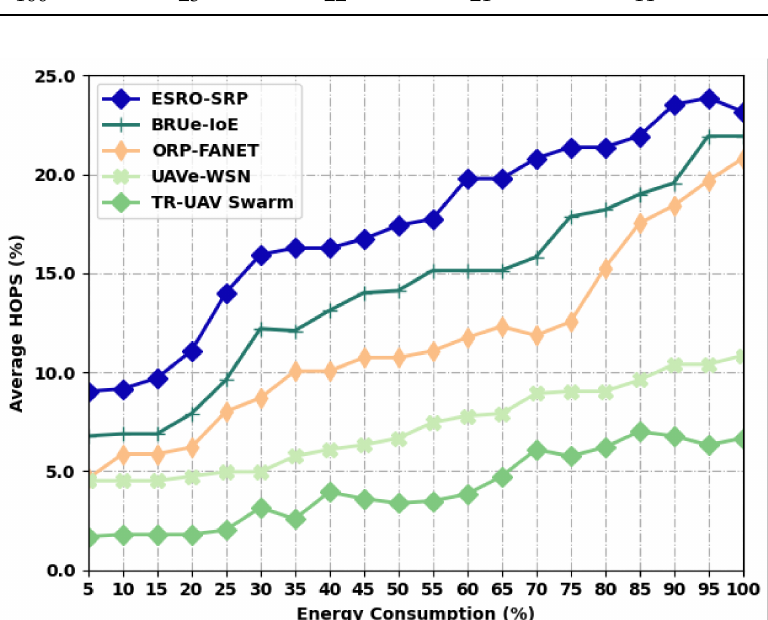
Figure 4. AHOPS analysis of ESRO-SRP technique under distinct levels of